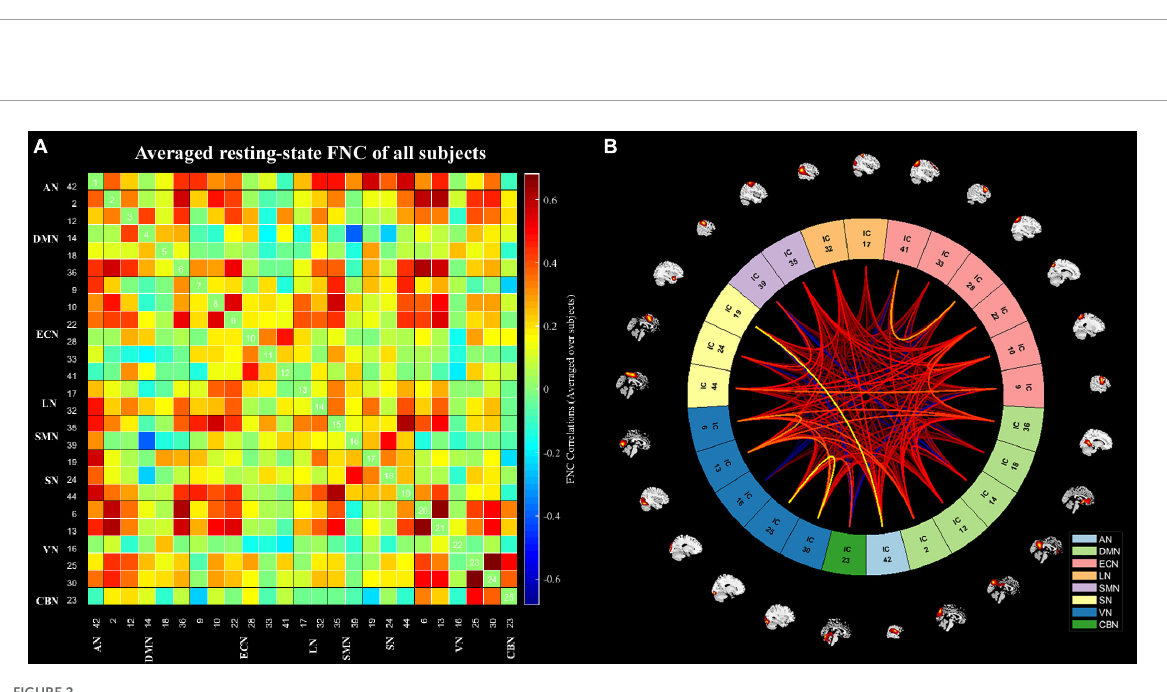
FIGURE2 The static functional network connectivity results. (A) The averages static functional network connectivity matrices of all subjects between independent components pairs was produced in entire resting-state time courses. (B) The mean static functional network connectivity of all subjects in eight network (single sample t -test) ( p < 0.01, FDR correction). AN, auditory network; DMN, default mode network; ECN, executive control network; LN, language network; SMN, sensorimotor network; SN, salience network; VN, visual network; CBN, cerebellar